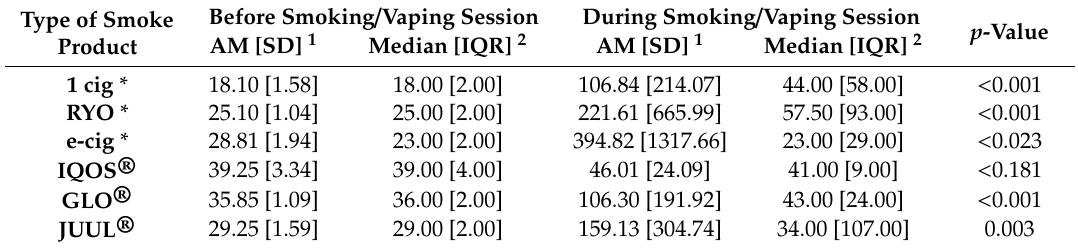
Table 1. Outdoor PM 1 levels ( µ g m − 3 ) for each device, before and during each smoking / vaping